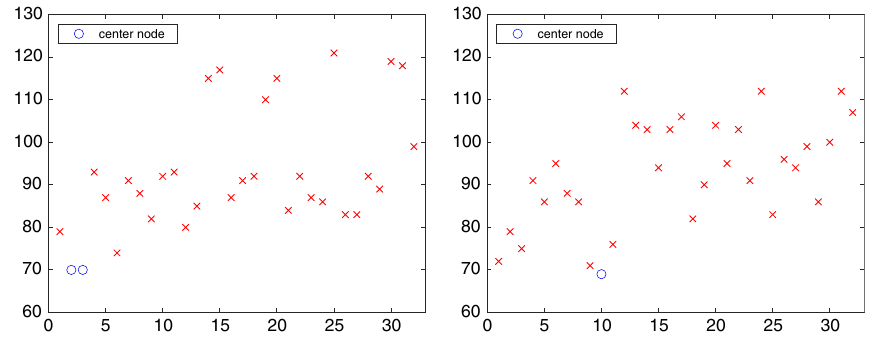
Fig. 11 Network ibm32: out-position centrality for p = 1 (left) and in-position centrality for p = 1 (right) for each vertex v k , k = 1,2, ... ,32 . The out-center vertices are v 2 , v 3 , and the in-center vertex is v 10